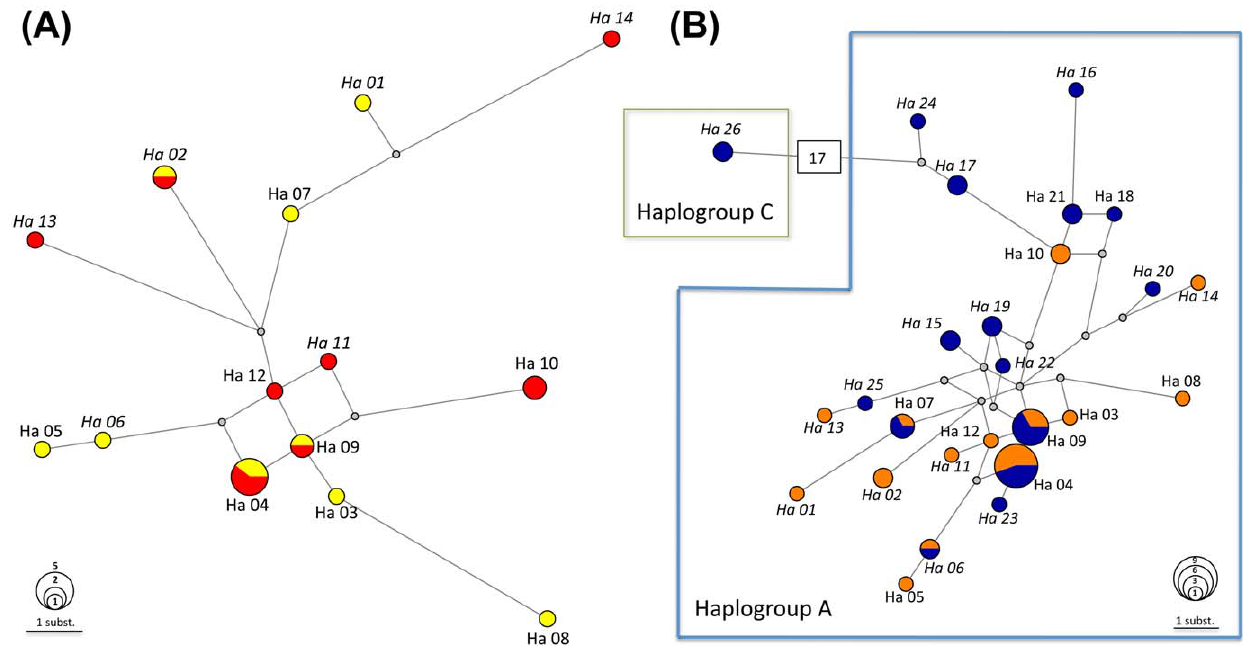
Figure 3. Networks generated with CR sequences of Corsican goats from A) medieval samples only or B) combined with present- day samples. The circles are proportional to the number of sequences obtained and colours indicated the period: yellow corresponds to XII th century, red to XIV th century, orange to all medieval and blue to present-day sequences. See Table 1 for details about haplotypes and archeological samples. Haplotypes indicated in italics are those only observed in Corsica up to now. Haplotype Ha 26 is the only one from the haplogroup C and differs from the closer haplotype by 17 positions that is materialized by a square with this number.